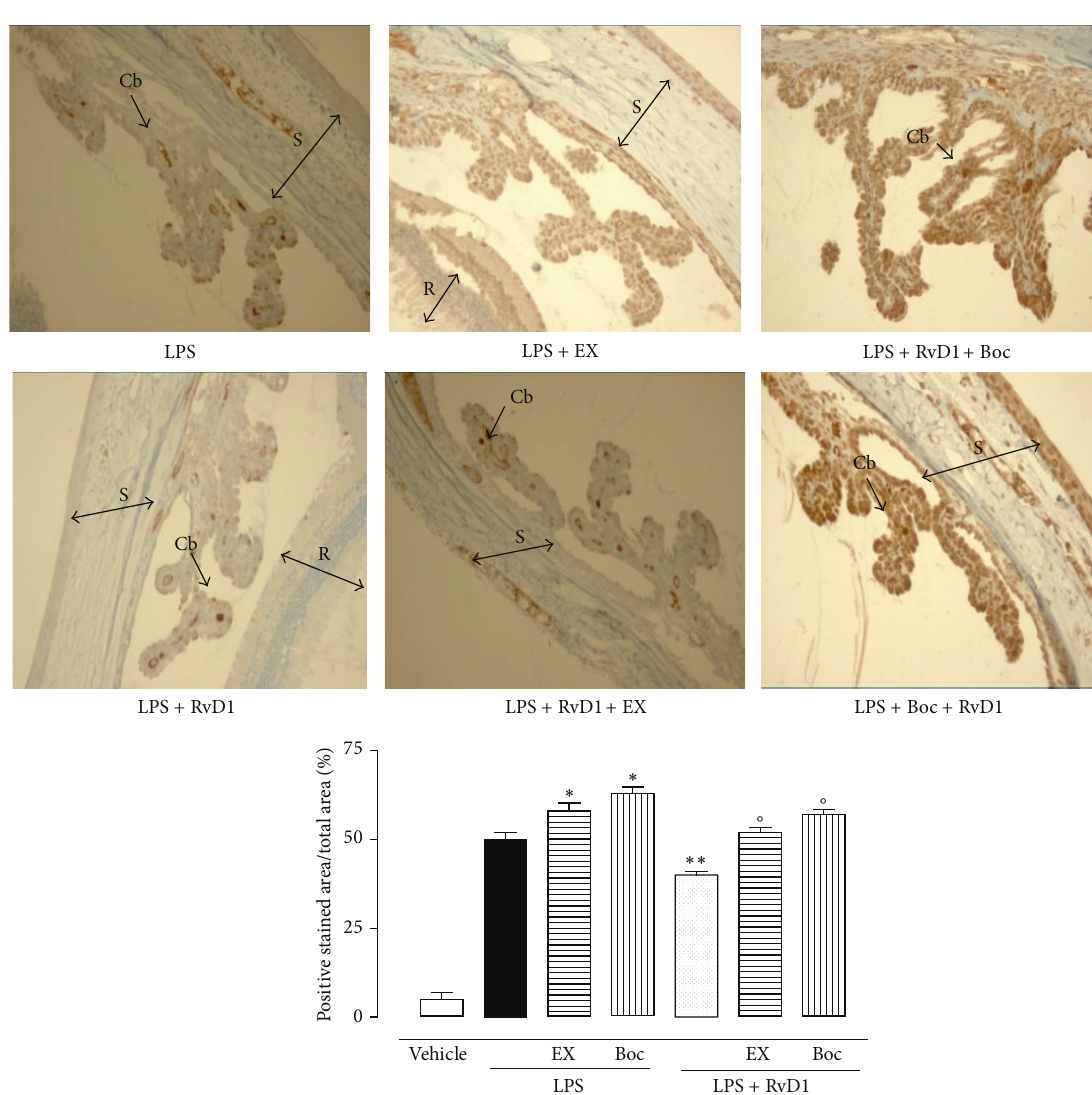
Figure 4: Representative immunohistochemistries of ocular tissues showing p53 in LPS rats alone; LPS + RvD1 (1000ng/kg); EX-527 + LPS + RvD1 (1000 ng/kg); Boc2 + LPS + RvD1 (1000ng/kg). RvD1 decreased p53 expression, as shown by the percentage of stained area per total area analyzed. The addition of EX-527 and Boc2 increases the expression of p53 with respect to LPS alone, while they decrease the expression of this factor if administered prior to LPS + RvD1 (1000ng/kg). Values are mean ± S.E.M. of 𝑛 = 6 observations for each group. ∗ 𝑃 < 0.05 and ∗∗ 𝑃 < 0.01 versus LPS-treated group, while differences versus LPS + RvD1 1000ng/kg groups are shown as ∘ 𝑃 < 0.01 . CB = ciliary body; R = retina; S = sclera; EX = Ex527; Boc = Boc2; RvD1 = resolvin